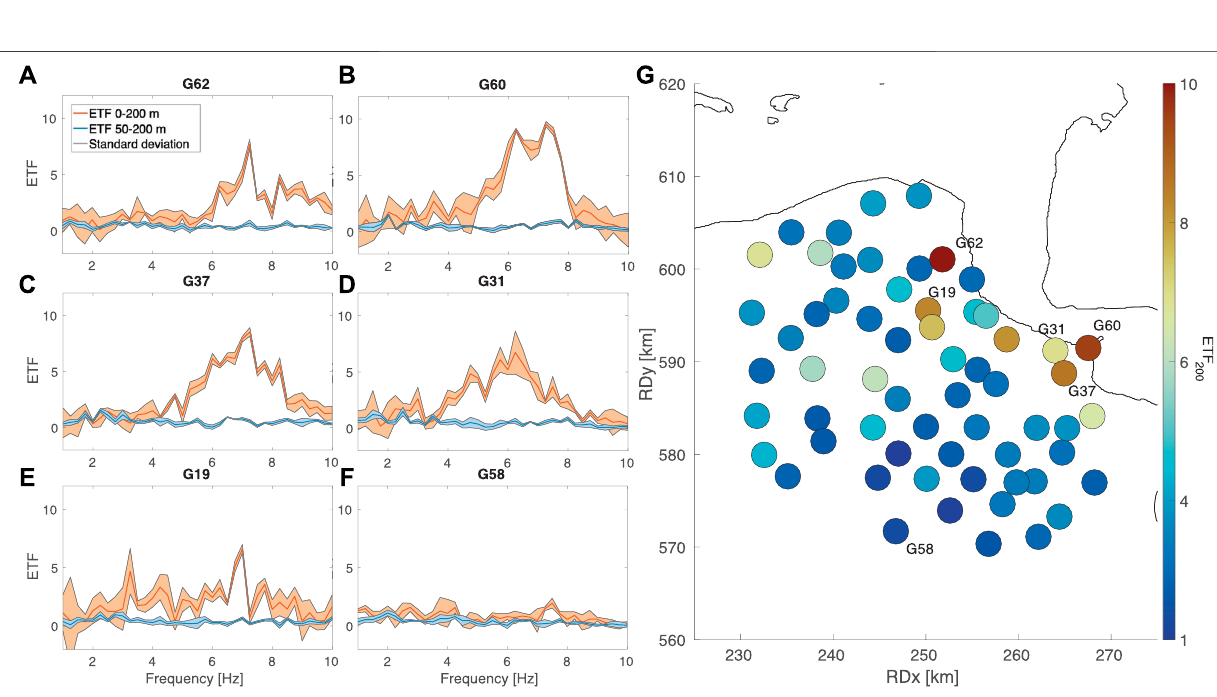
investigated in the following sections.